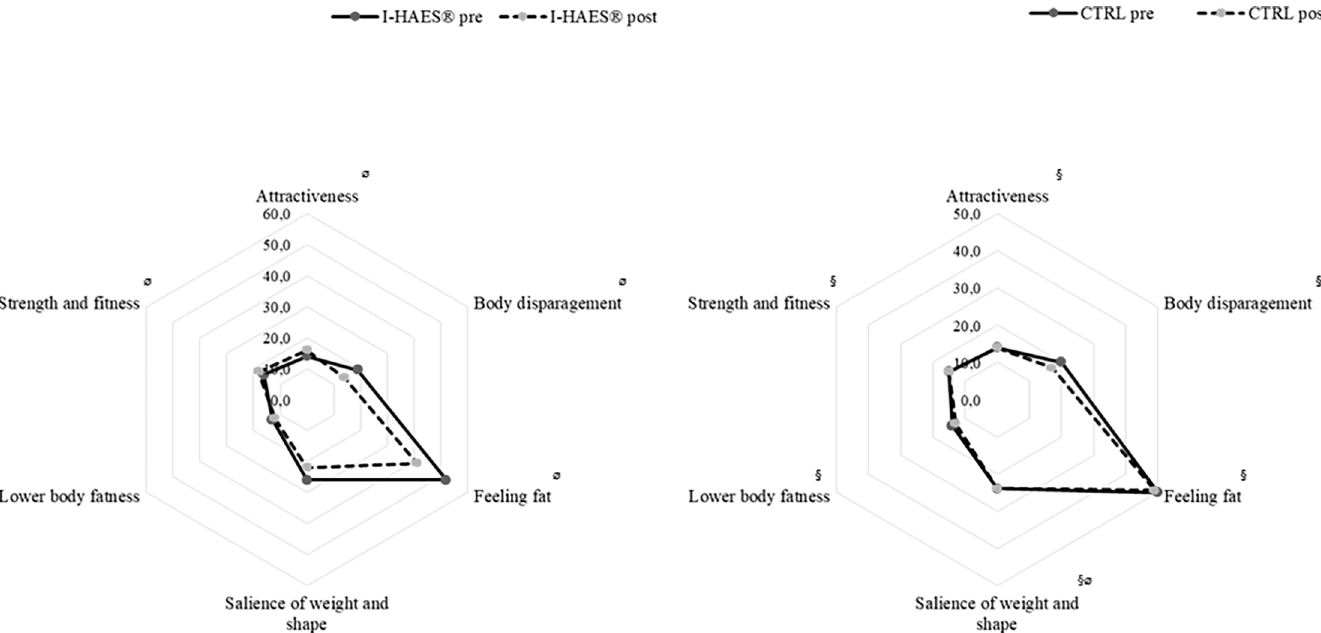
Fig 3. (Left panel): Results from the intensified HAES 1 -based intervention group Body Attitude Questionnaire pre- and post-intervention. (Right panel): Results from the control group Body Attitude Questionnaire pre- and post-intervention. I-HAES 1 , intensified HAES 1 -based intervention group; CTRL, control group. § Significant difference when compared to the intensified HAES 1 -based intervention group post-intervention (P (cid:20) 0.05). ø Significant difference within group (P (cid:20) 0.05).